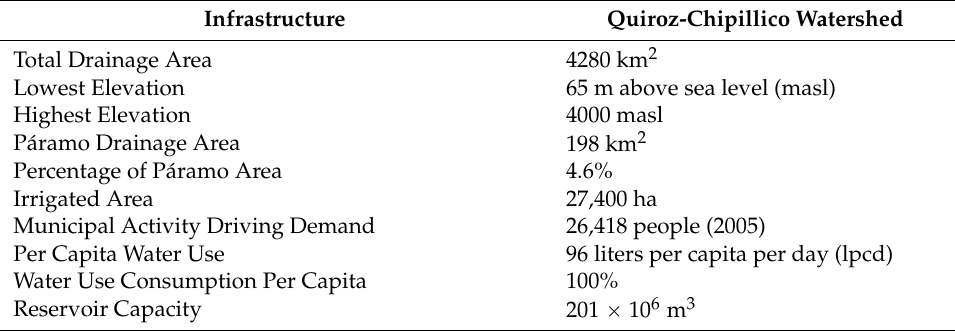
Table 1. Descriptive information of the study area.